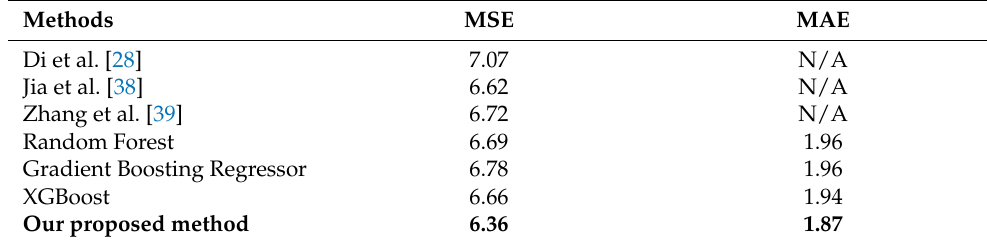
Table 3. Experimental results on the 2016 PHM dataset.